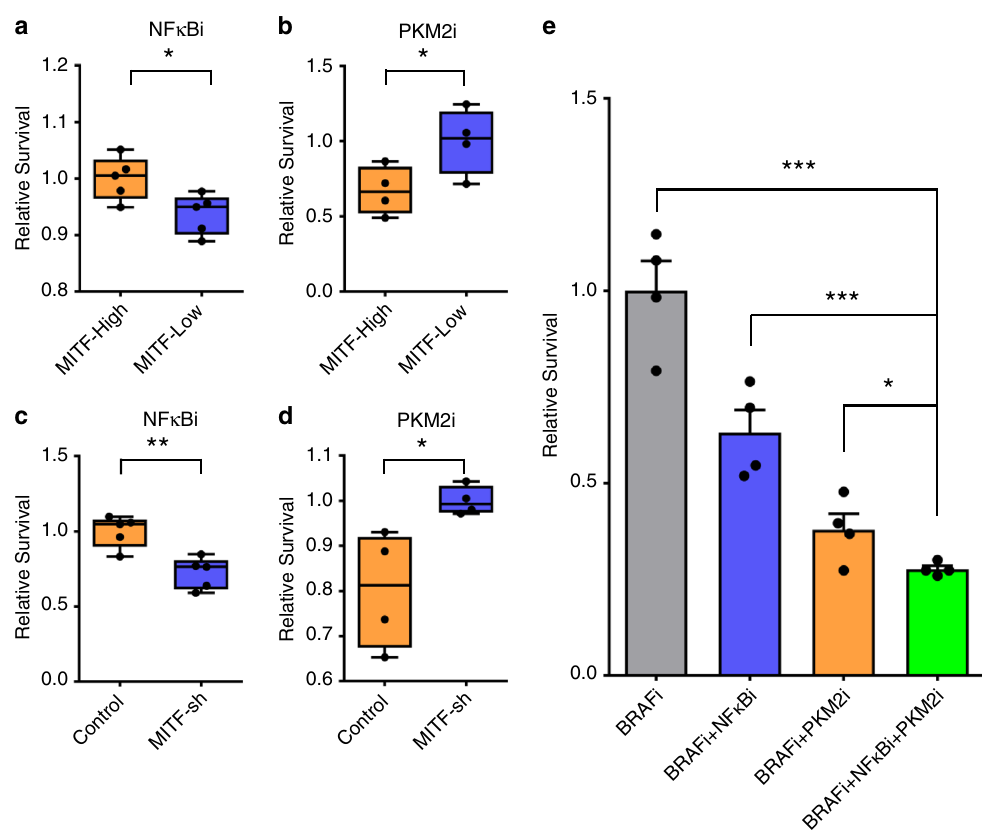
Fig. 5 Differential drug sensitivity of cells associated with two trajectories. a MITF-GFP reporter cell line was sorted for MITF-High and MITF-Low subpopulations before drugging. The sorted cells were then treated with BRAFi + NF κ Bi combination for 5 days and then collected for cell number counting. Relative cell survival of sorted MITF-High and MITF-Low cells after undergoing BRAFi + NF κ Bi combination therapy for 5 days were plotted. Survival data were normalized to the MITF-High sample. Each experiment is the result of n = 4 biologically independent samples per group. b MITF-GFP reporter cell line was sorted for MITF-High and MITF-Low subpopulations before drugging. The sorted cells were then treated with BRAFi + PKM2i combination for 5 days and then collected for cell number counting. Relative cell survival of sorted MITF-High and MITF-Low cells after undergoing BRAFi + PKM2i combination therapy for 5 days were plotted. Survival data were normalized to the MITF-Low sample. Each experiment is the result of n = 4 biologically independent samples per group. c MITF-knockdown cells and control cells were treated with BRAFi + NF κ Bi combination for 5 days and then collected for cell number counting. Relative cell survival of sorted control and MITF-sh cells after undergoing BRAFi + NF Κ Bi combination therapy for 5 days were plotted. Survival data were normalized to the control sample. Each experiment is the result of n = 5 biologically independent samples per group. d MITF-knockdown cells and control cells were treated with BRAFi + PKM2i combination for 5 days and then collected for cell number counting. Relative cell survival of sorted control and MITF-sh cells after undergoing BRAFi + PKM2i combination therapy for 5 days were plotted. Survival data were normalized to the MITF-sh sample. Each experiment is the result of n = 4 biologically independent samples per group. For boxplots in a – d , data are median with fi rst and third quartiles (box), and top and bottom quartiles (whiskers) indicated. e M397 cell treated with BRAFi, BRAFi + NF Κ Bi, BRAFi + PKM2i, and BRAFi + NF κ Bi + PKM2i for 5 days were collected for cell number counting. Relative cell survival of cells after undergoing BRAFi, BRAFi + NF κ Bi, BRAFi + PKM2i, or BRAFi + PKM2i + NF κ Bi therapy for 5 days were plotted. Survival data were normalized to cells undergoing BRAFi monotherapy treatment. Each experiment is the result of n = 4 biologically independent samples per group. The P -value was determined by a two-tailed unpaired Student ’ s t -test, * P < 0.05, ** P < 0.01, *** P < 0.001. Data are presented as mean values ± SEM. Source data are provided as a Source Data fi